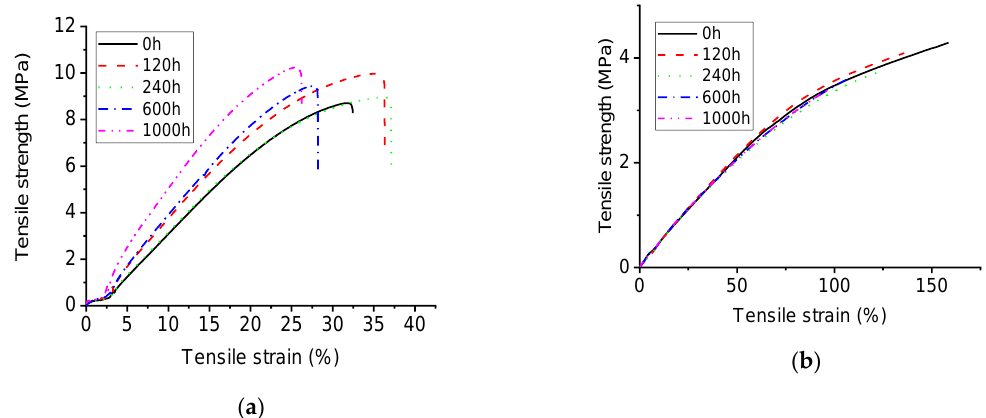
Figure 6. Tensile and elongation at break of two samples: (a) alicyclic epoxy resin; (b) HTVSR.